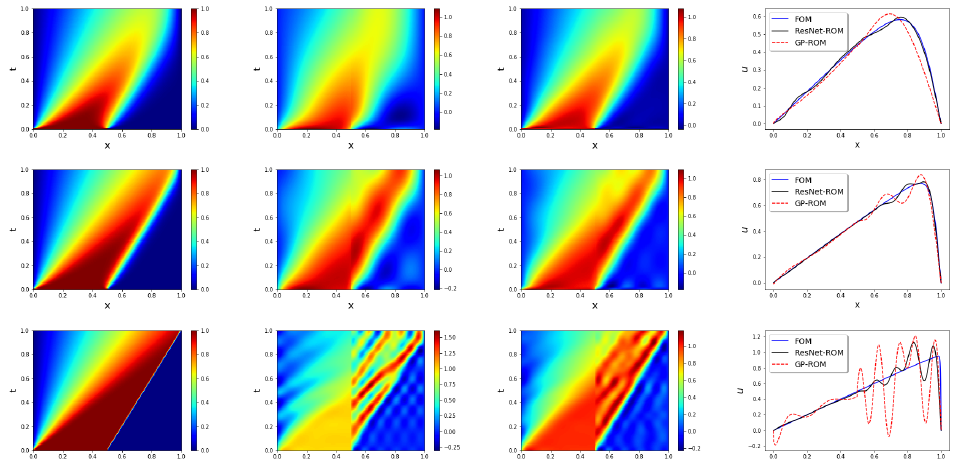
Figure 5. Predictive regime: ROMs are trained on data from Re = [ 20,50,100,200,500,800,1000 ] and are tested at Re = 30 ( first row ), Re = 80 ( second row ), Re = 1200 ( third row ). Results presented for FOM ( first column ), GP-ROM ( second column ), ResNet-ROM ( third column ), and final time solution for all three simulations ( fourth column ).